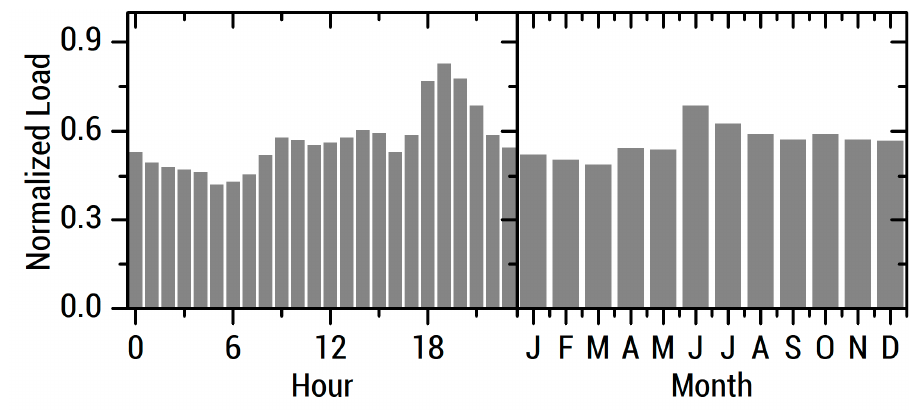
Figure A2. Daily and monthly average of the normalized load profile.